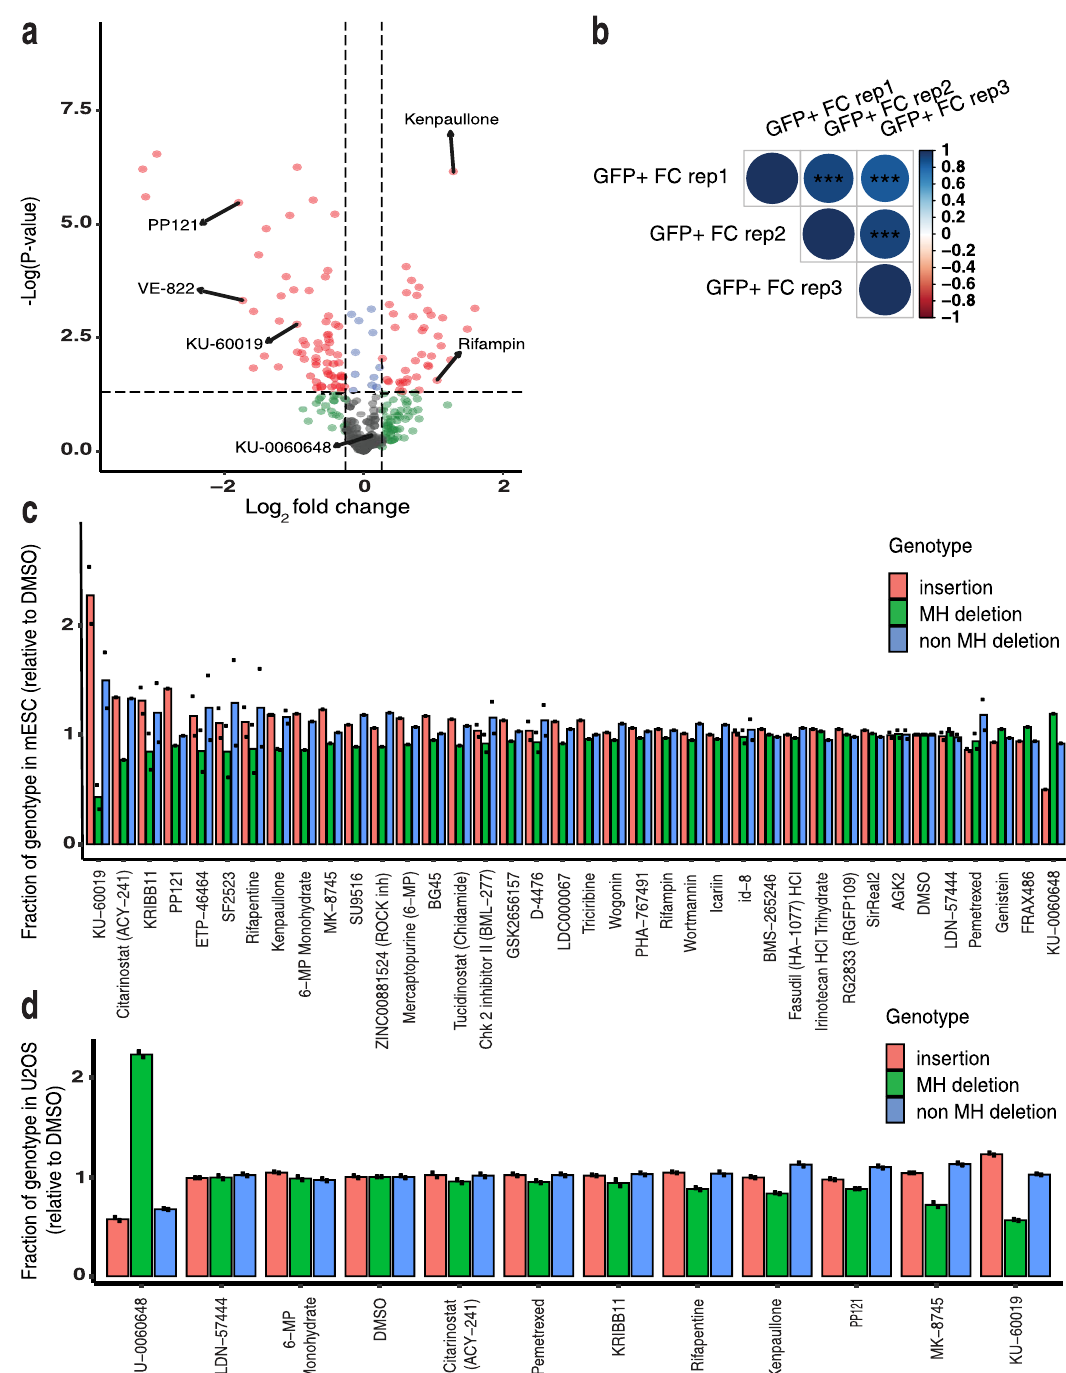
Fig. 1 Identi fi cation of small molecules that alter SpCas9 mutational outcomes. a Volcano plot exhibiting the log2 fold changes (FC) in GFP + cells relative to the DMSO control for the 318 small molecules at 2 µ M. Small molecules yielding a (less than or greater than) log2 FC of 0.26 of normalized GFP activity and a p value <0.05 were identi fi ed as hits and are exhibited as red dots. P values calculated using two-sided Welch ’ s t-test. b Replicate consistency of FC GFP + population for assay at 2 µ M concentration ( N = 3). FC was normalized by the GFP signal from DMSO-treated wells. Spearman correlation, p value < 0.0001. Average fraction of each genotype among edited reads relative to DMSO observed in mESC ( c ) or U20S ( d ) transfected with the 48-site library ( N = 1 or N = 2 biologically independent samples, as shown). *** p <